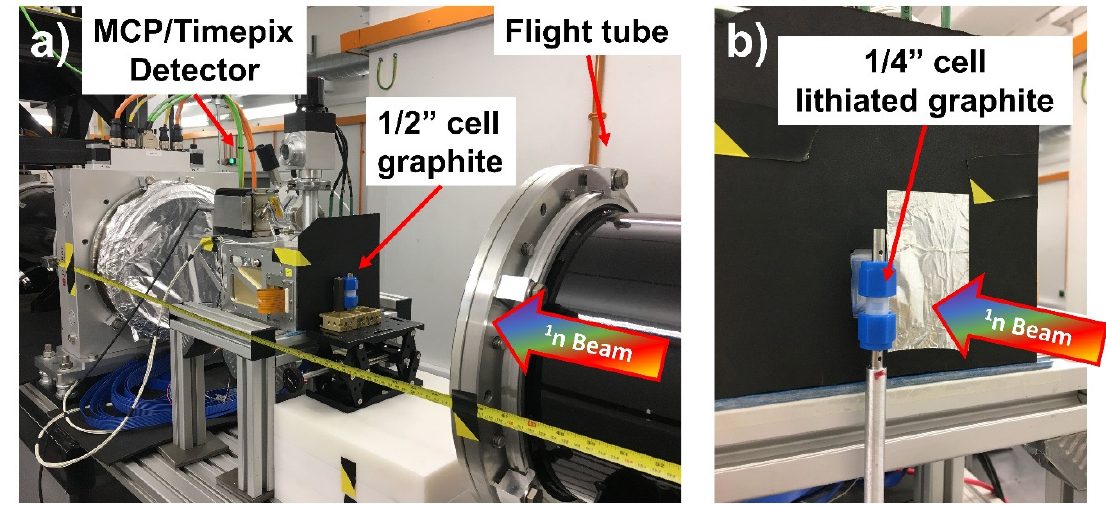
Figure 1. Experimental set-up at the “5 m position” on IMAT. ( a ) MCP / Timepix detector installed 5.4 m downstream from the pinhole collimator, and a 1 / 2” Swagelok cell in front of the detector; ( b ) 1 / 4” Swagelok cell mounted on an Al rod on top of a rotation stage for tomography.